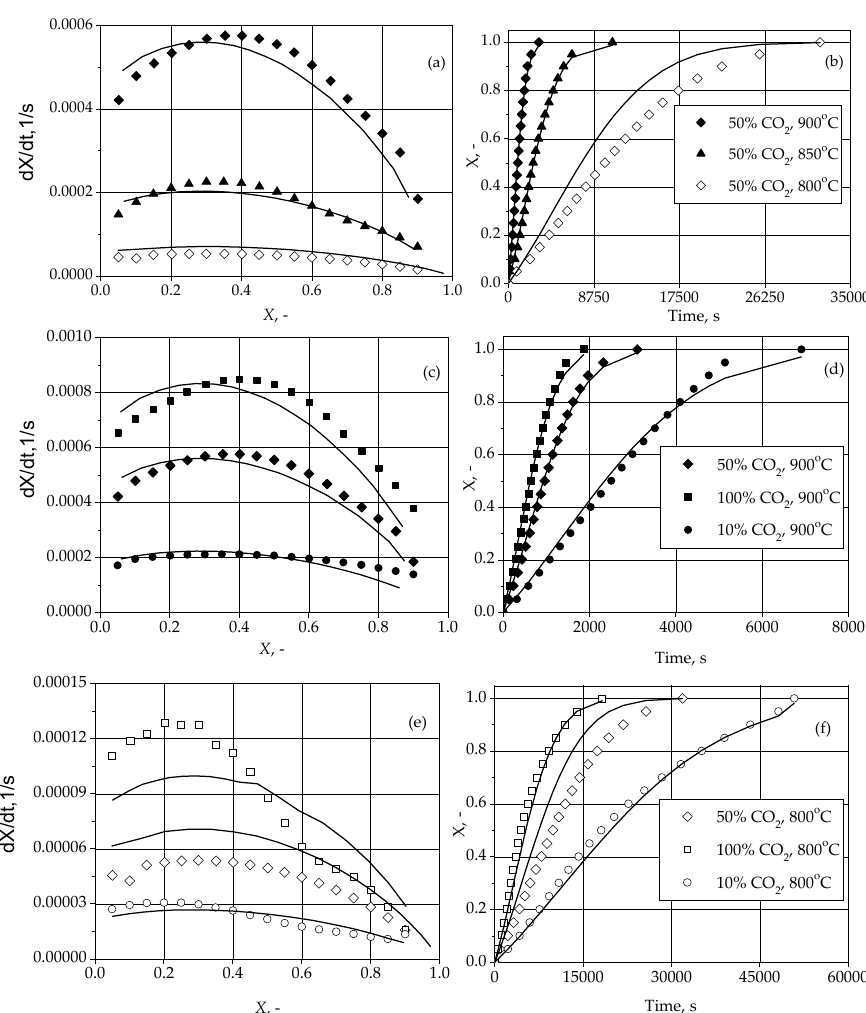
Figure 4. E ff ect of temperature and gasifying agent concentration on conversion ( b , d , f ) and RPC char reactivity in the CO 2 gasification reaction ( a , c , e ). Figure 4. Effect of temperature and gasifying agent concentration on conversion ( b,d,f ) and RPC char reactivity in the CO 2 gasification reaction ( a,c,e ).